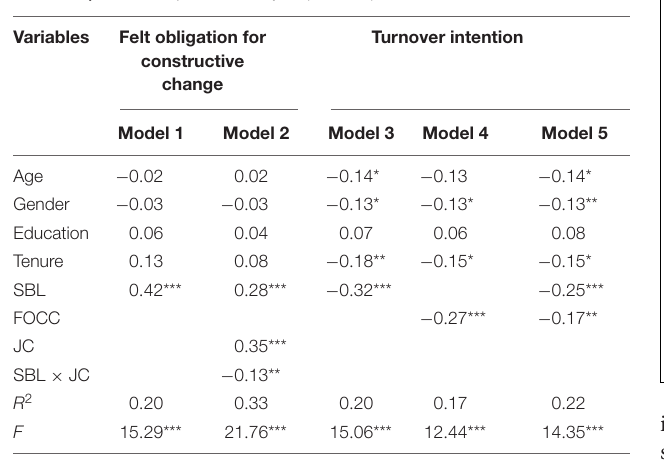
TABLE 4 | Results of process analysis ( N = 317).